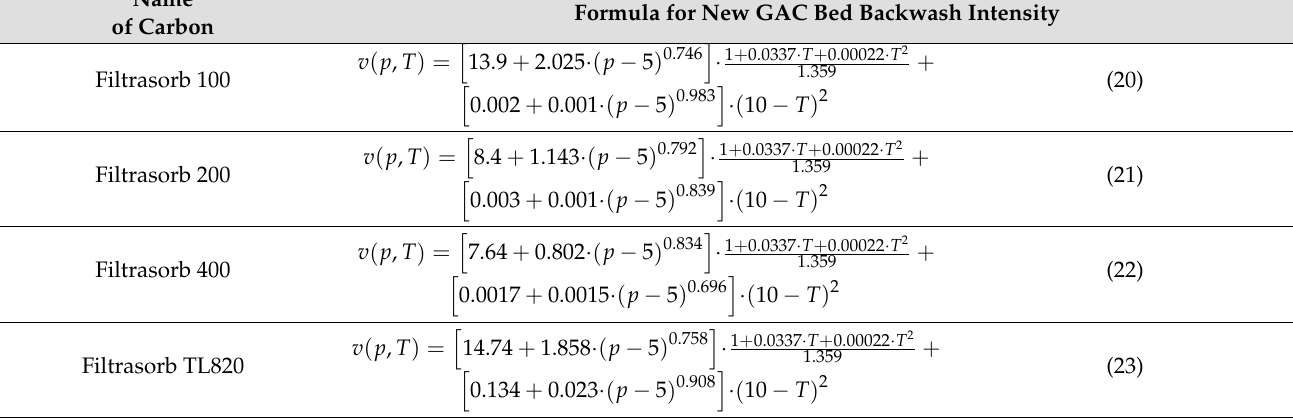
Table 9. Approximation equations for backwash intensity as a function of water temperature t and bed expansion p taken from